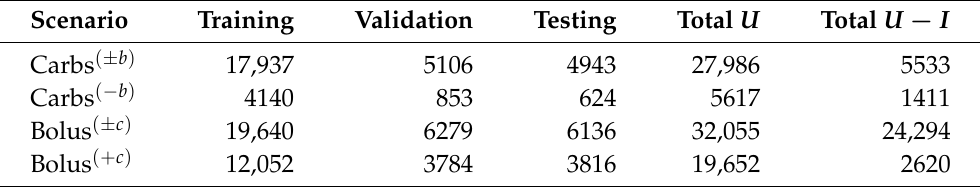
Table 4. Unrestricted (U) examples by recommendation scenario, also showing, in the last column, the total number of non-inertial ( U − I ) examples. Carbs ( ± b ) refers to all carbohydrate intake events; Carbs ( − b ) refers to carbohydrate intakes without a